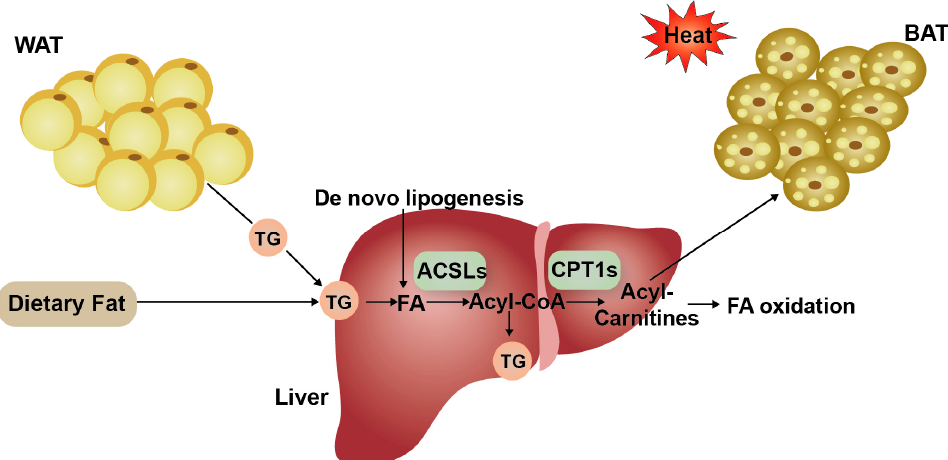
Figure 7. Schematic diagram of liver fatty acid (FA) oxidation. Liver FAs are mainly derived from dietary lipids, adipose tissue decomposition, and de novo synthesis. FAs are activated by long-chain acyl-CoA synthetases (ASCL) to form acyl-CoA molecules, which can undergo oxidation or be incorporated into complex lipids. Acyl-CoA is transferred to mitochondria by carnitine palmitoyltransferase 1 (CPT1), and then, Acyl-CoA converts Acyl-Carnitines, which can partition to brown adipose tissue (BAT) for heat generation or continually into FA oxidation.